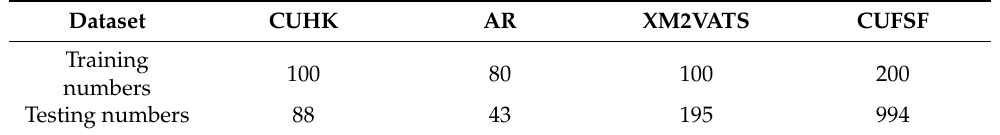
Table 1. Partition of